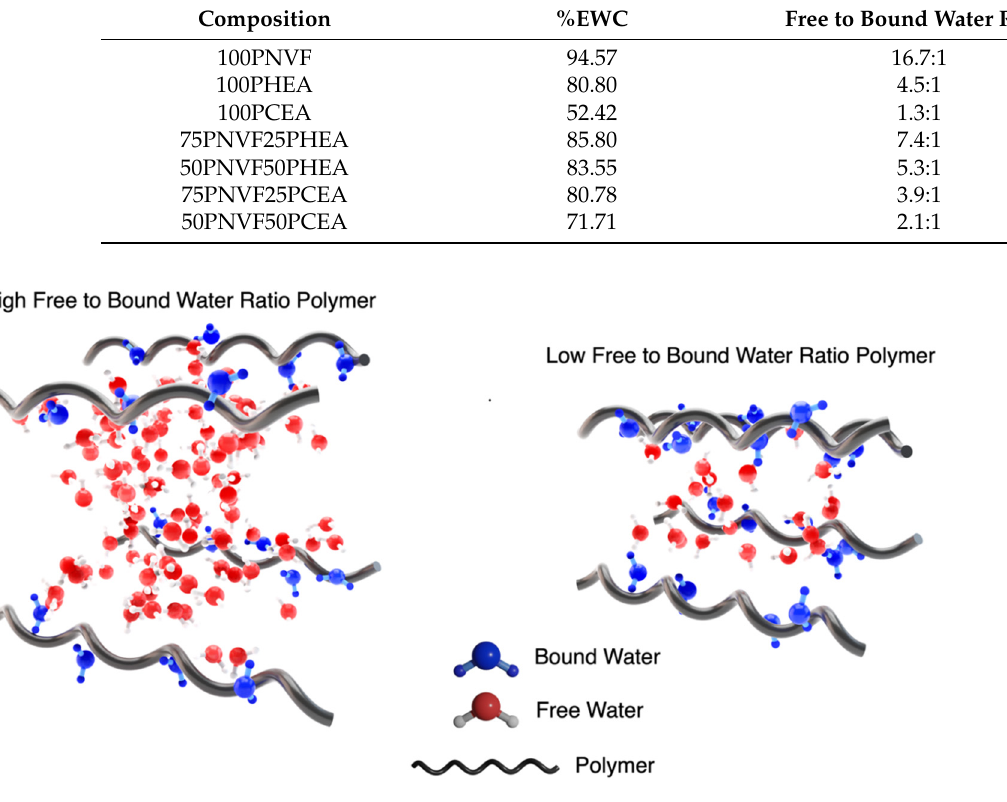
Table 2. %EWC and free to bound water ratio of the hydrogel samples.